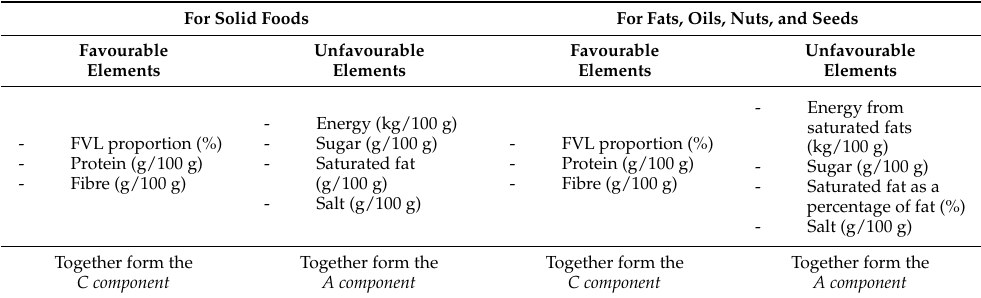
Together form the C component A component FVL: Fruit, vegetable, and legume. For both food groups, points are given for three favourable elements, which together form the C component . Points are also given for four unfavourable elements, which together form the A component